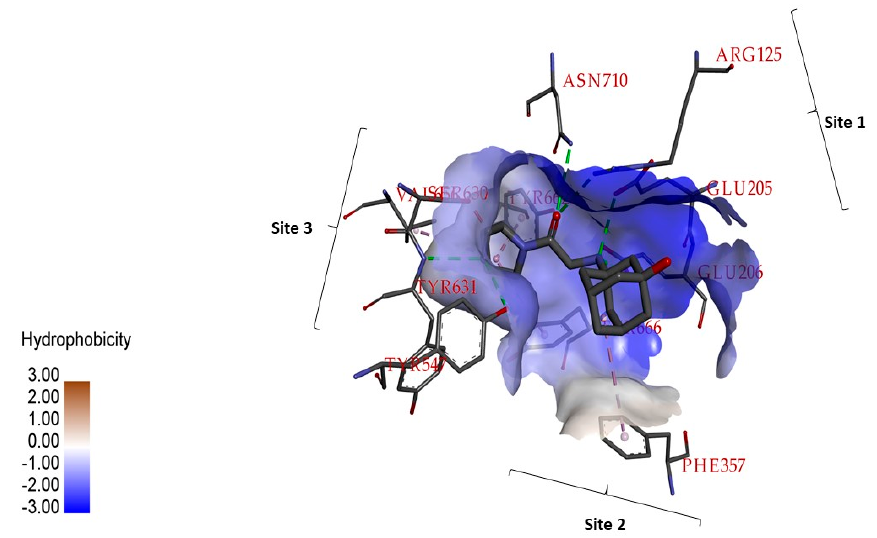
Figure 1. The important residues responsible for dipeptidyl peptidase-4 (DPP-4) inhibition, hydrophobic surface feature active site of DPP-4. Vildagliptin binding DPP-4 structure was